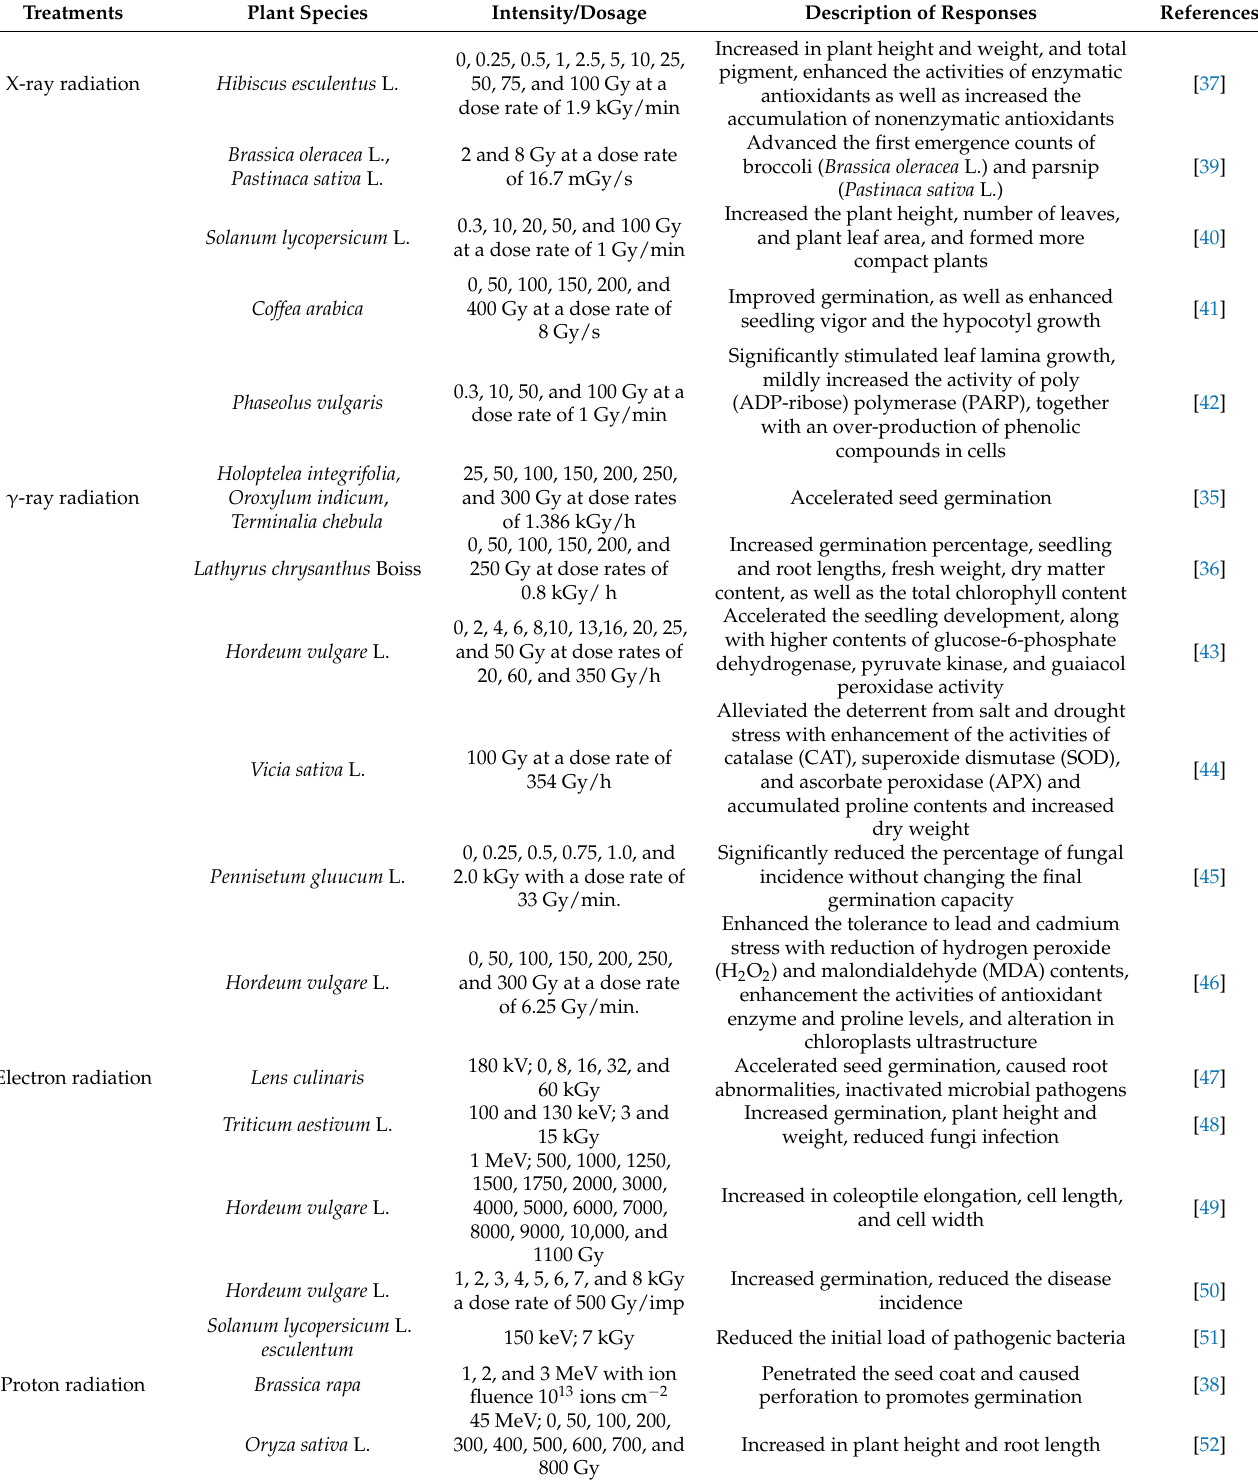
Table 2. Summary of plant responses upon seed priming with ionizing physical